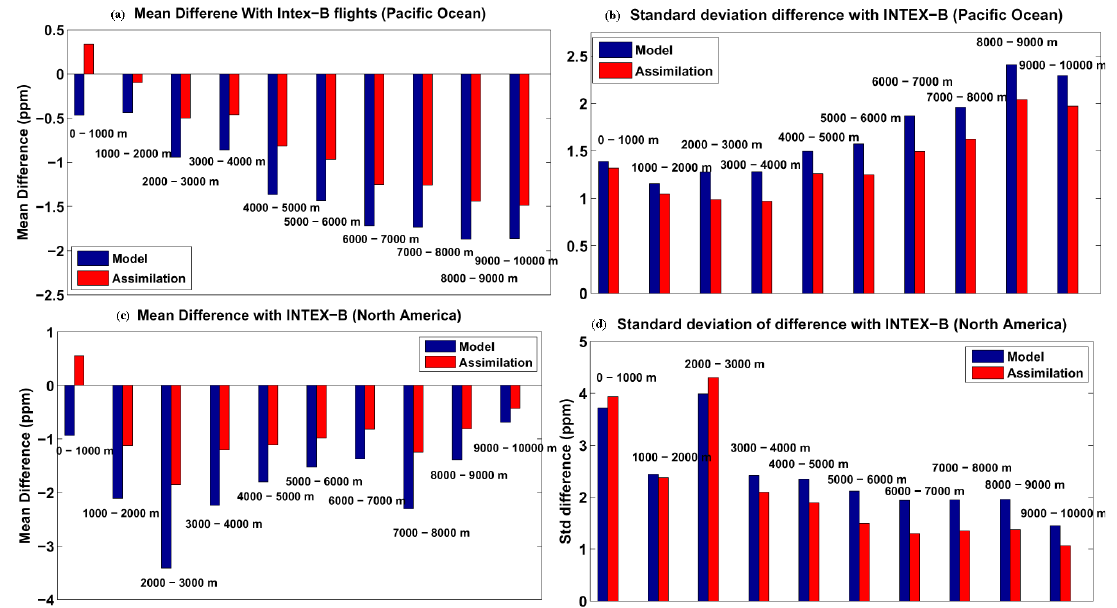
Fig. 10. Mean (a) and standard deviation (b) of difference (Observation − Analysis) between the INTEX-B campaign measurements and CO 2 from the GEOS-5 model (or assimilation) interpolated to observation locations over the Pacific Ocean, during the period February–May 2006. The same plots but with observations restricted to the flights over North America are shown in (c) and (d) .